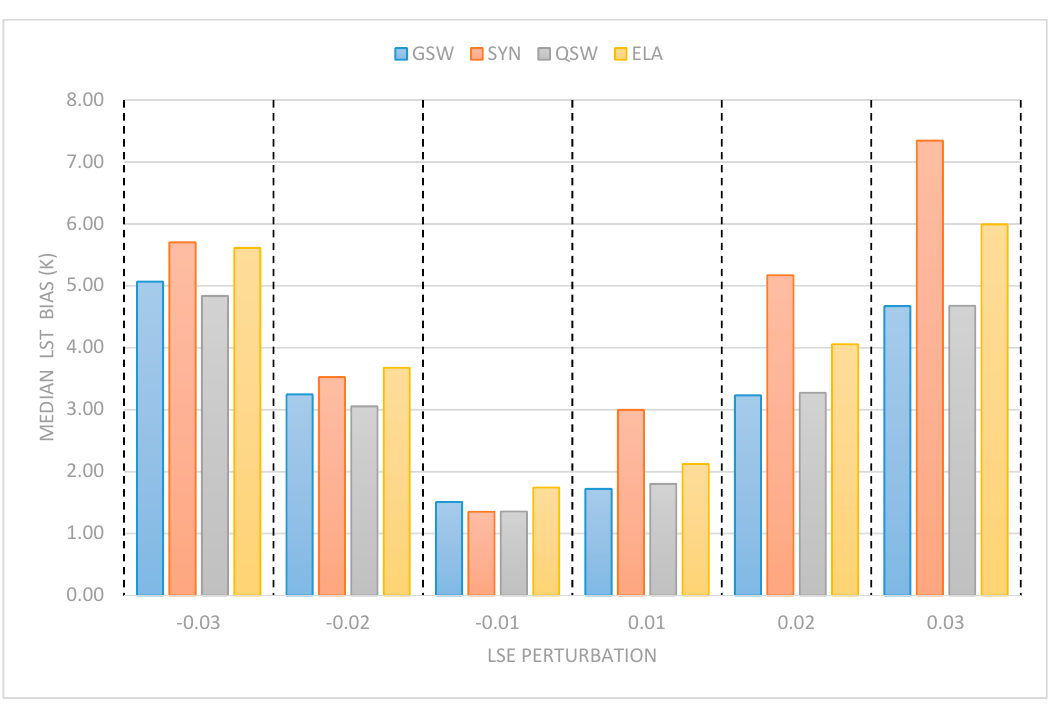
Figure 7. The median LST biases (K) for the GSW, SYN, QSW and ELA algorithms (which explicitly ingest LSE) for set perturbations of LSE. Perturbation difference from the value given to the algorithm as opposed to the actual value of the pixel in the dataset.